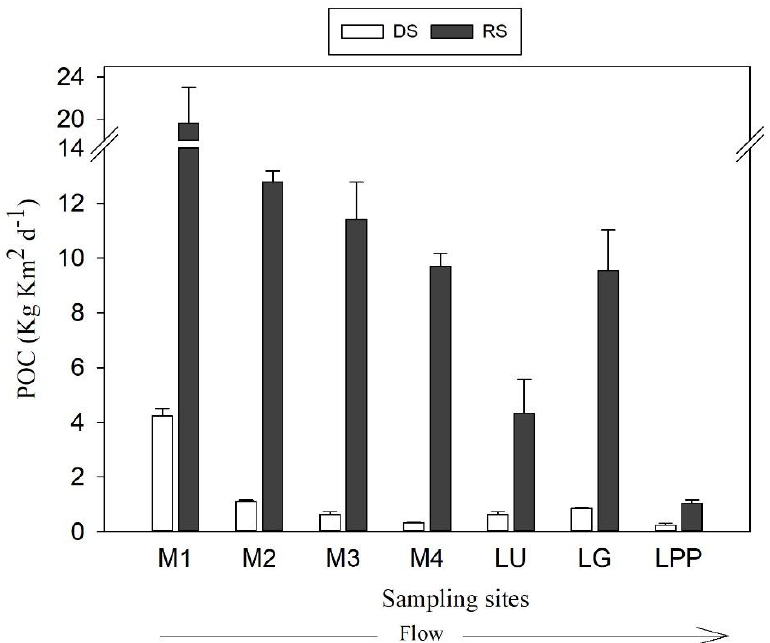
Figure 7. Seasonal and spatial distributions of POC yield in the Usumacinta River basin. Bars represent average yields and whiskers represent the standard deviations.